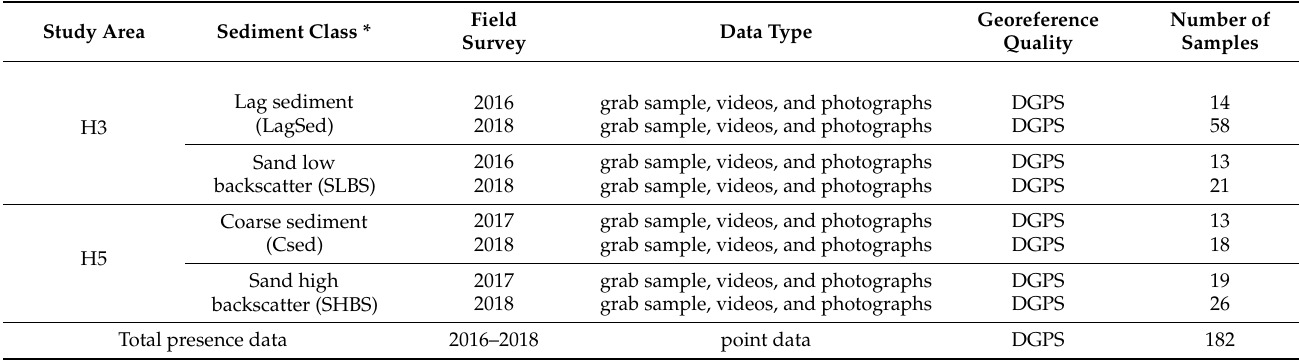
Table 3. Summary of the ground-truth datasets that were used for the class-specific ensemble models. All ground-truth data were georeferenced to the spatial resolution of the DGPS ( ± 0.25 m) of the research